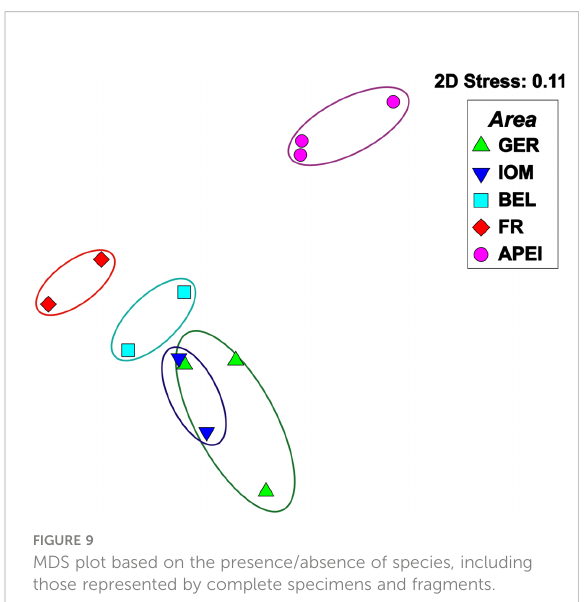
FIGURE 9 MDS plot based on the presence/absence of species, including those represented by complete specimens and